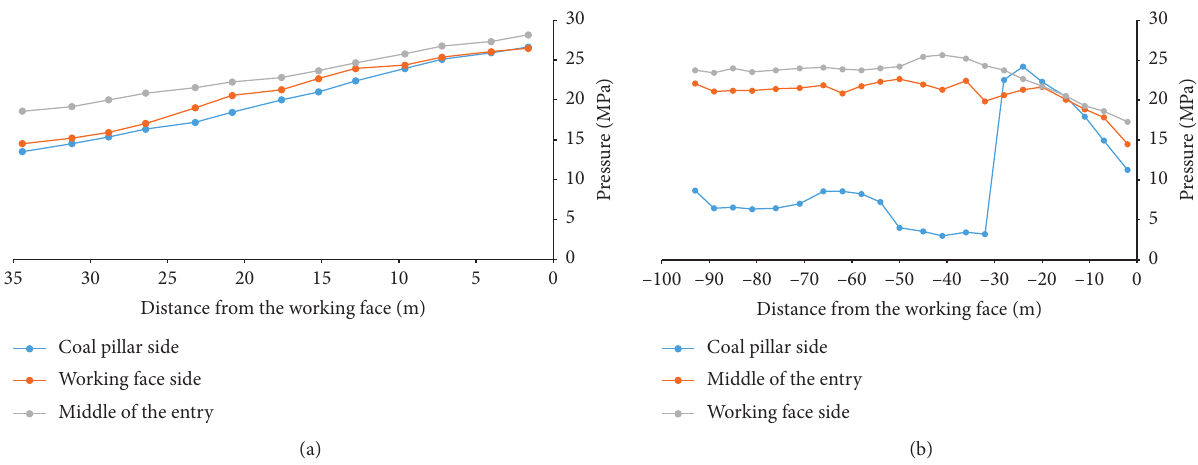
Figure 5: The pressure change curve of single hydraulic prop in advance support of entry. (a) Before mining. (b) After mining.